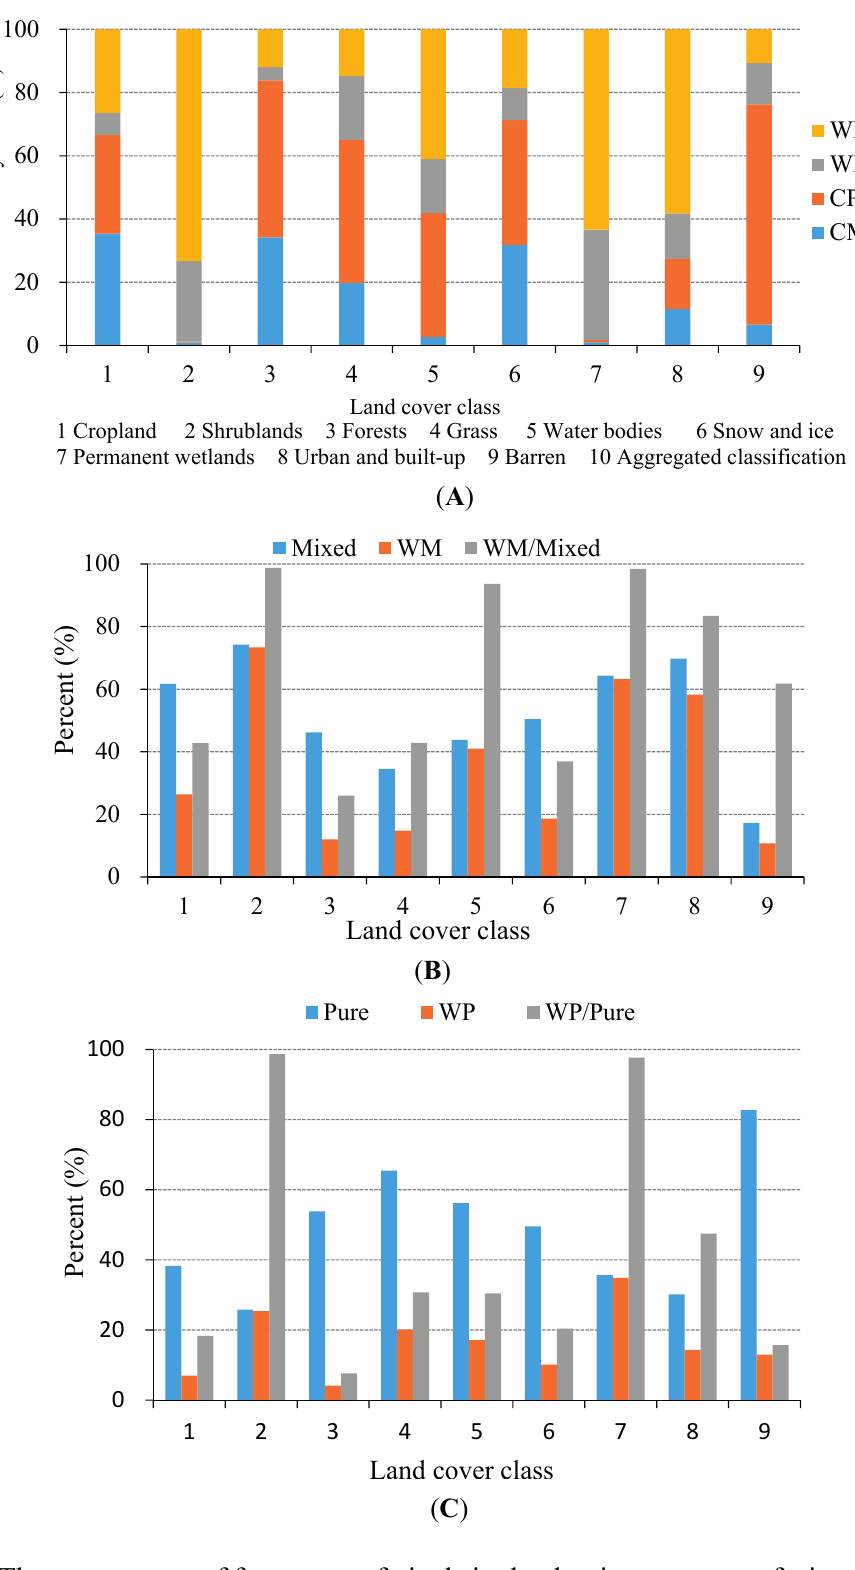
Figure 8. The percentages of four types of pixels in the dominant-type confusion matrix and the ratios between WMs and the mixed pixels and between WPs and the pure pixels. ( A ) Percentages of the four types of pixels in the dominant-type confusion matrix. ( B ) Percentages of the mixed pixels, misclassified mixed pixels and their ratios. ( C ) Percentages of the pure pixels, misclassified pure pixels and their